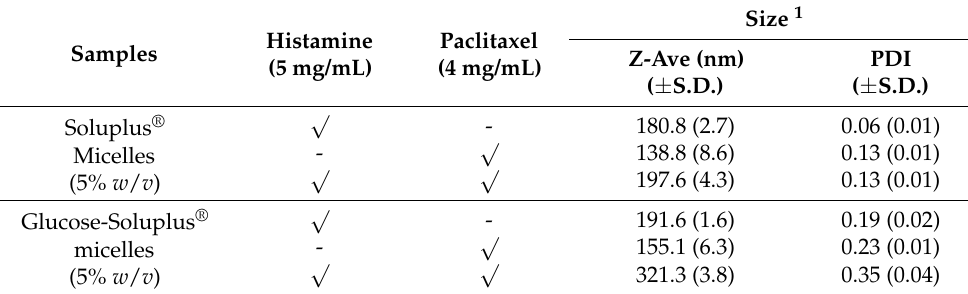
Table 2. Size and size distribution of nanosystems diluted 1/33 in a Hank’s solution (pH 7.4) to simulate the dilution process after i.v., administration measured by DLS at 37 ◦